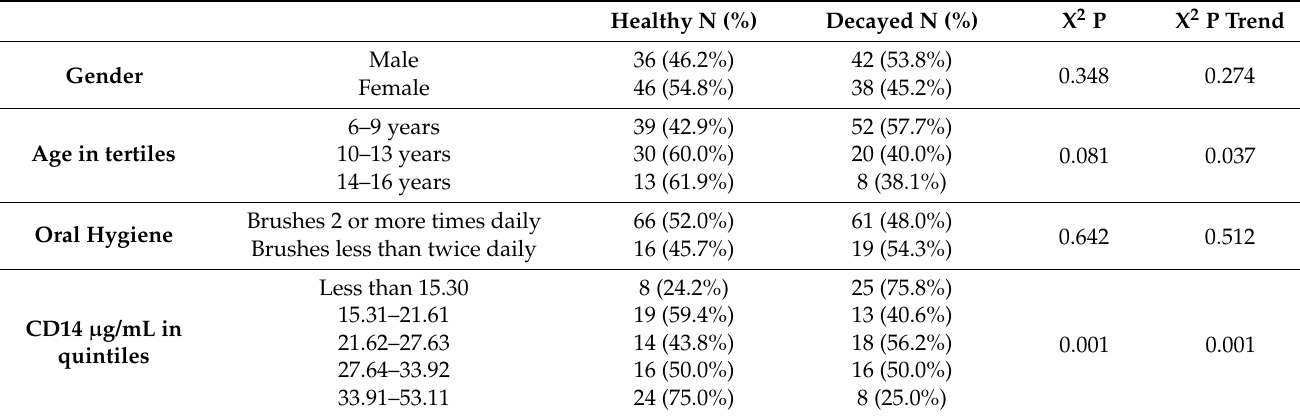
Table 1. Study population distribution with respect to oral health status according to sex, age in three groups, oral hygiene, and sCD14 in quintiles, with Chi-square, and Chi-square test for proportional trends p -values. Healthy N (%) Decayed N (%) X 2 P X 2 P Trend Gender